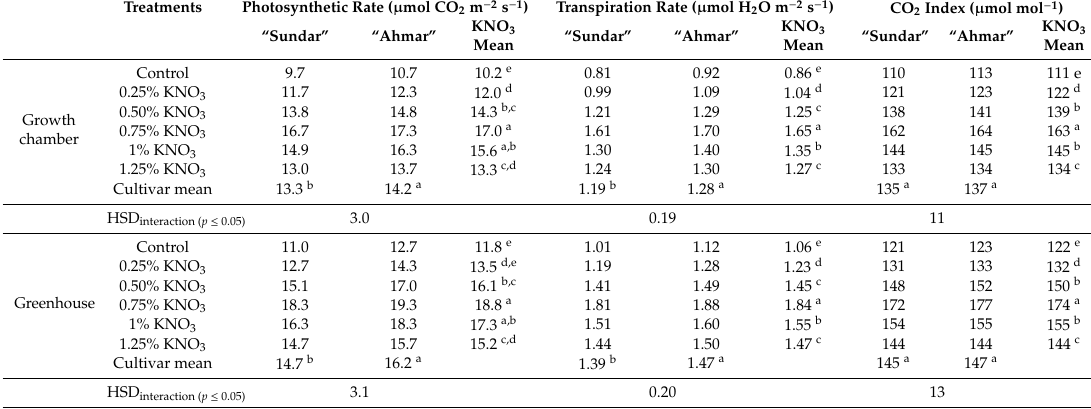
Table 3. Variations in physiological attributes of two tomato cultivars under the influence of seed priming with KNO 3 in two di ff erent growth conditions.